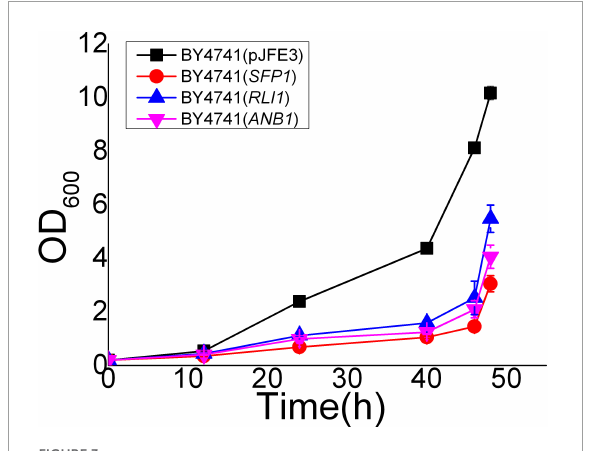
FIGURE3 Vanillin resistance profiles of recombinant strains which overexpress translation related genes in laboratory strain BY4741 grown in SC-URA liquid medium supplemented with 6 mM vanillin. Cultivations were performed at 30 ◦ C. The error bars indicated the standard deviation of independent